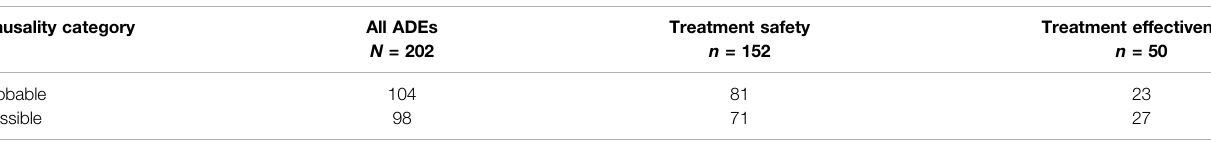
TABLE 8 | Causality assessment of ADEs.